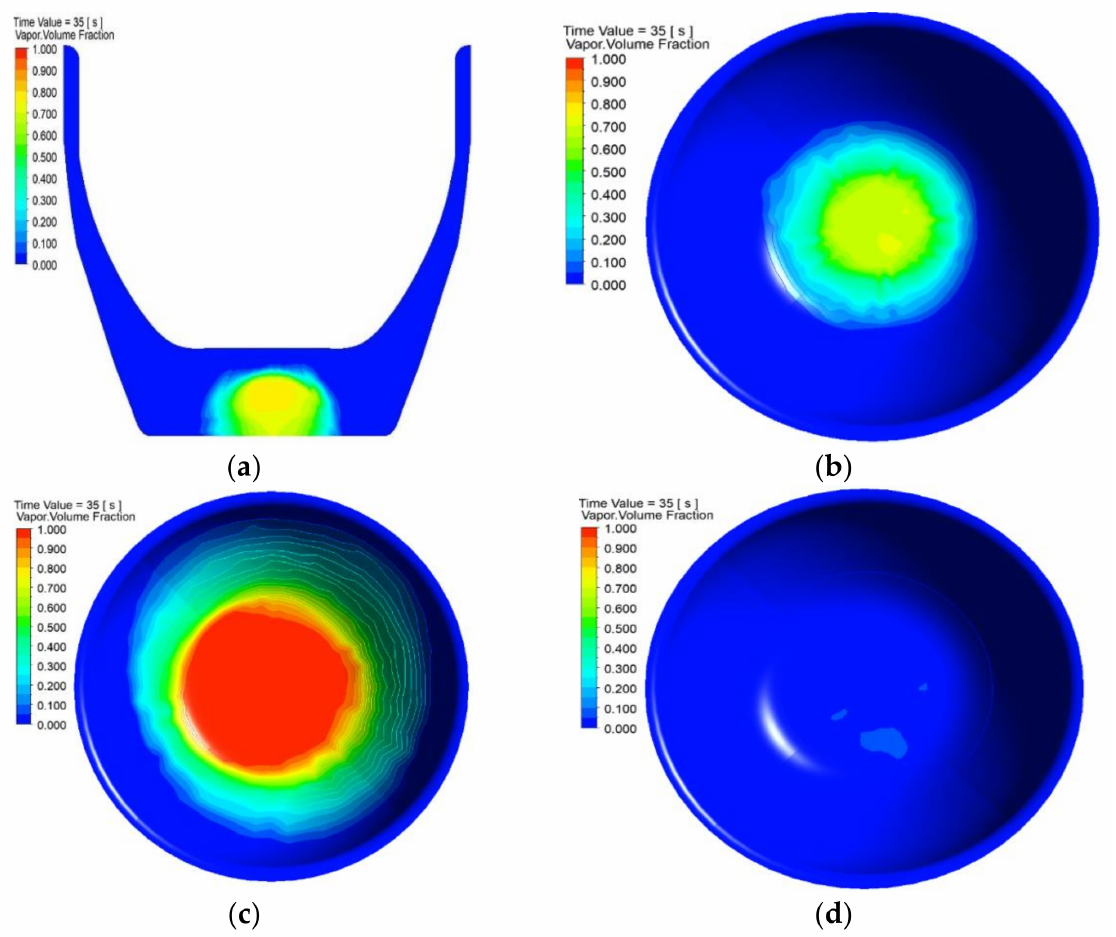
Figure 16. Vapor volume fraction of the inside wall with varying VF and Q, Model 1. ( a ) VF = 10%, Q = 10 W. ( b ) VF = 30%, Q = 10 W. ( c ) VF = 30%, Q = 20 W. ( d ) VF = 50%, Q = 10